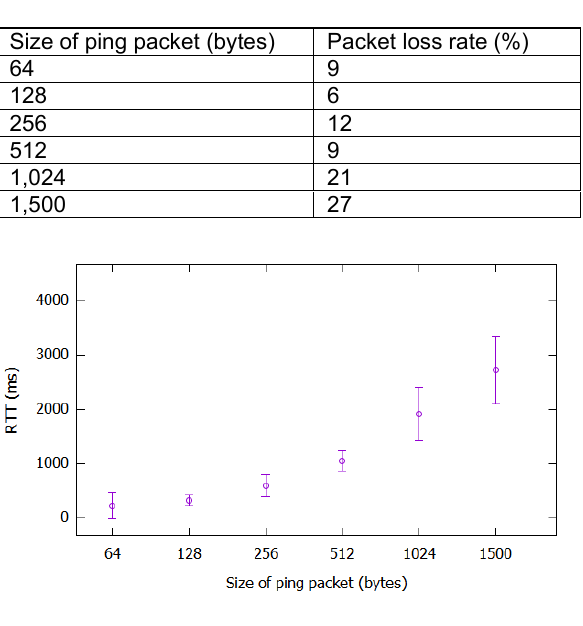
Figure 8. Comparison of average TCP connection time (error bars representing standard deviation) according to the size of the download in the range of 1,000 bytes to 10,000 bytes.